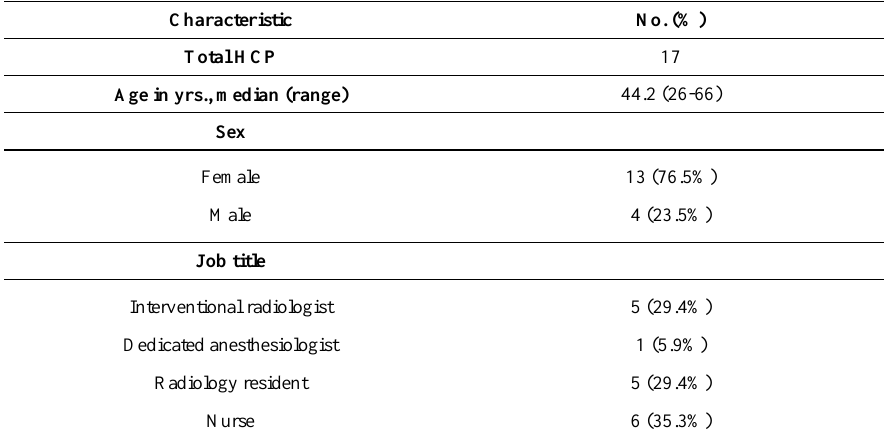
Table 1. Demographic characteristics and job titles of 17 healthcare personnel (HCP) specifically dedicated to